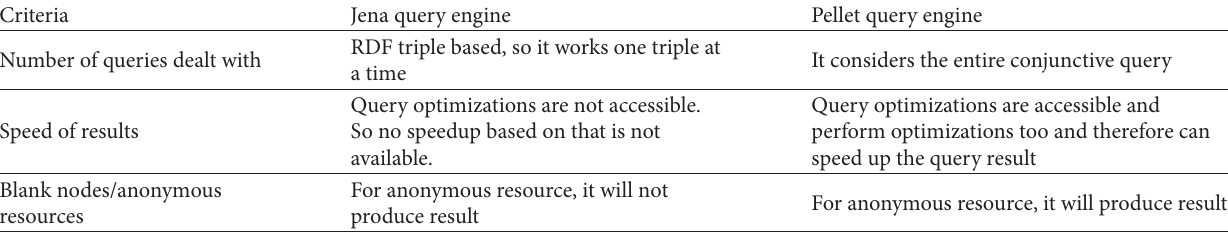
Table 1: Comparison of jena query engine and Pellet query engine.